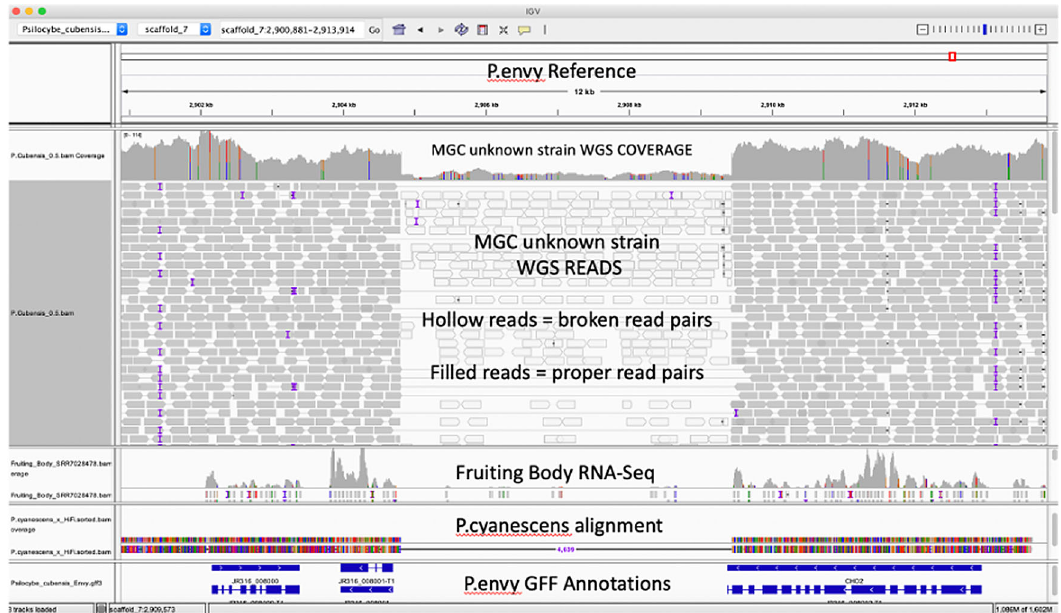
Figure3.IGVdisplayofIlluminareadsmappedtoHiFi Psilocybecubensis P.envyassembly. ToptrackisMedicinal Genomics Illumina whole genome shotgun data of a different P. cubensis (strain name unknown: NCBI Project: PRJNA687911) mapped to the HiFi P. cubensis strain P.envy. Second track contains RNA-Seq data from a third P. cubensis genome (strain name also unknown: NCBI Project: PRJNA450675) hosted at JGI. Third track is Psilocybe cyanescens genome mapped to HiFi P. cubensis P.envy reference genome. Fourth track is FunAnnotate GFF3 annotation of the HiFi P. cubensis P.envy